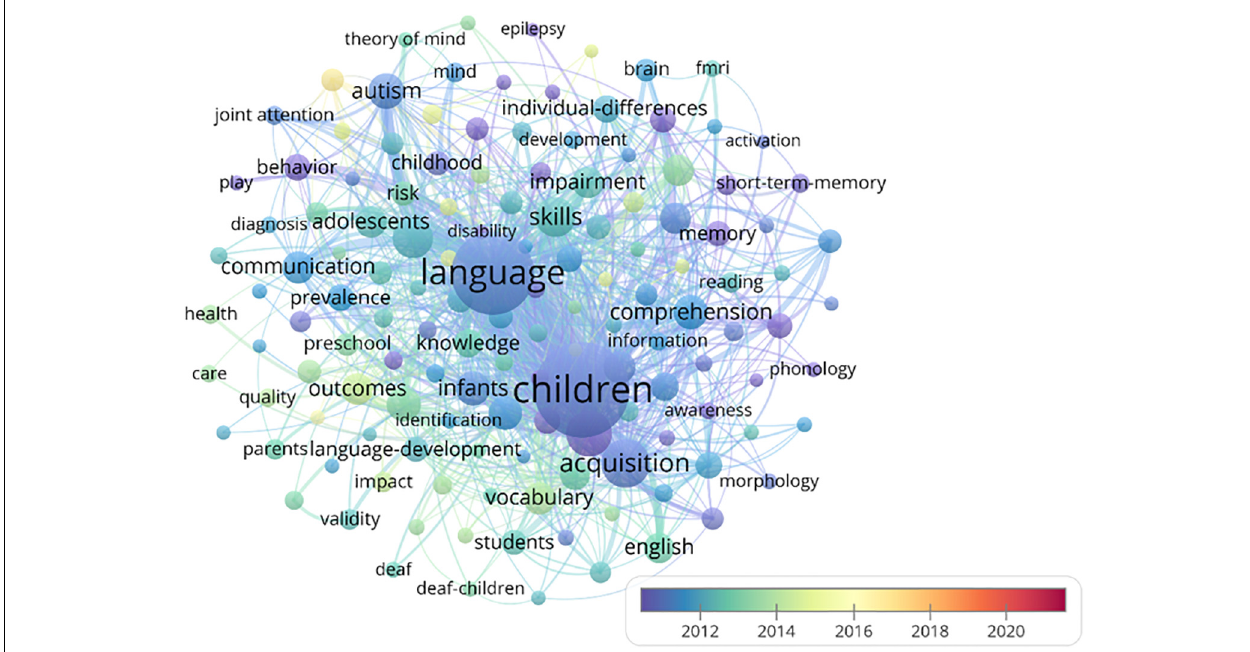
FIGURE 9 | Co-keyword network